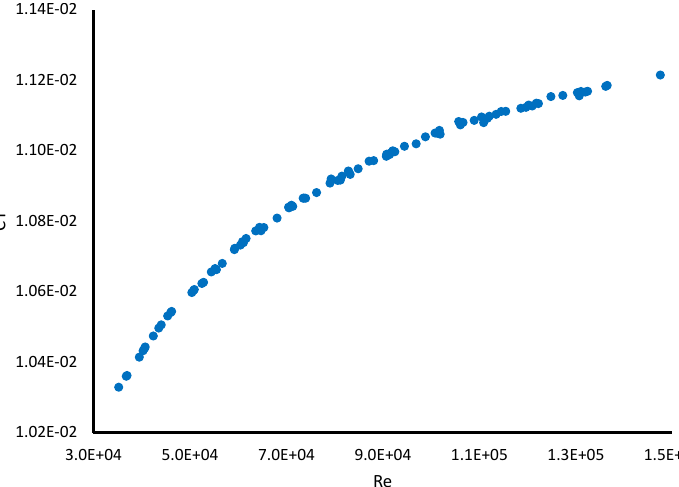
Figure 5. Computational results for thrust coefficient as a function of Re.